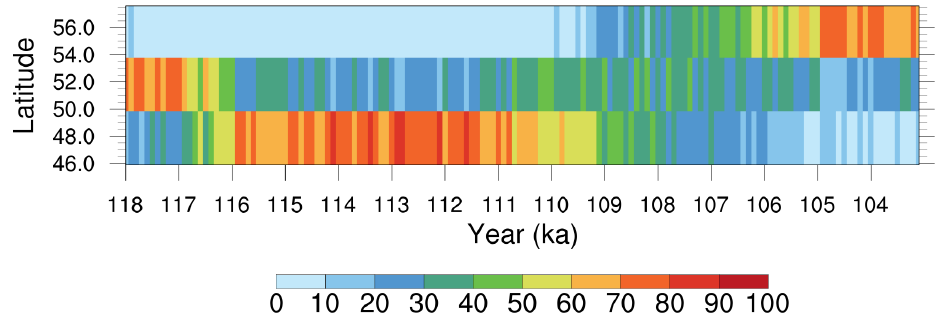
Figure 13. Ensemble distribution of mean most southern latitudinal position of the JJA jet of the Atlantic Ocean.